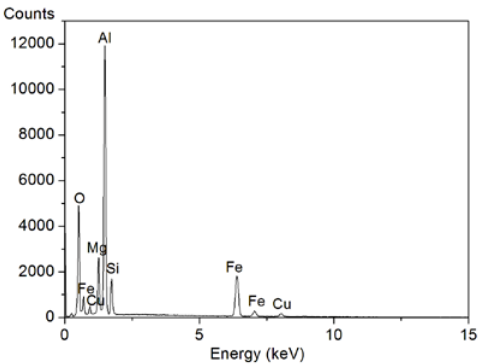
Figure 10. EDS result of wear surface of Mg 2 Si–Al composite fabricated by using semi-solid extrusion with isothermal heat treatment holding time of 160 min, with a sliding velocity of 1000 r/min.